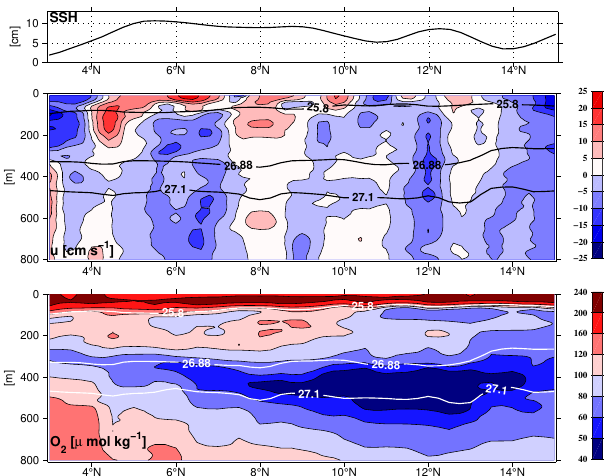
Figure 4. Sea surface height anomaly on 18 November 2009 in cm (top), zonal velocity component 15 to 21 November 2009 incms − 1 (middle) and oxygen content in µmolkg − 1 (bottom) at 23 ◦ W. Se- lected isopycnals σ θ = 25.8 and 27.1kgm − 3 for Central Water boundaries and σ θ = 26.88kgm − 3 for the tracer release density are included as black (middle panel) and white (lower panel)